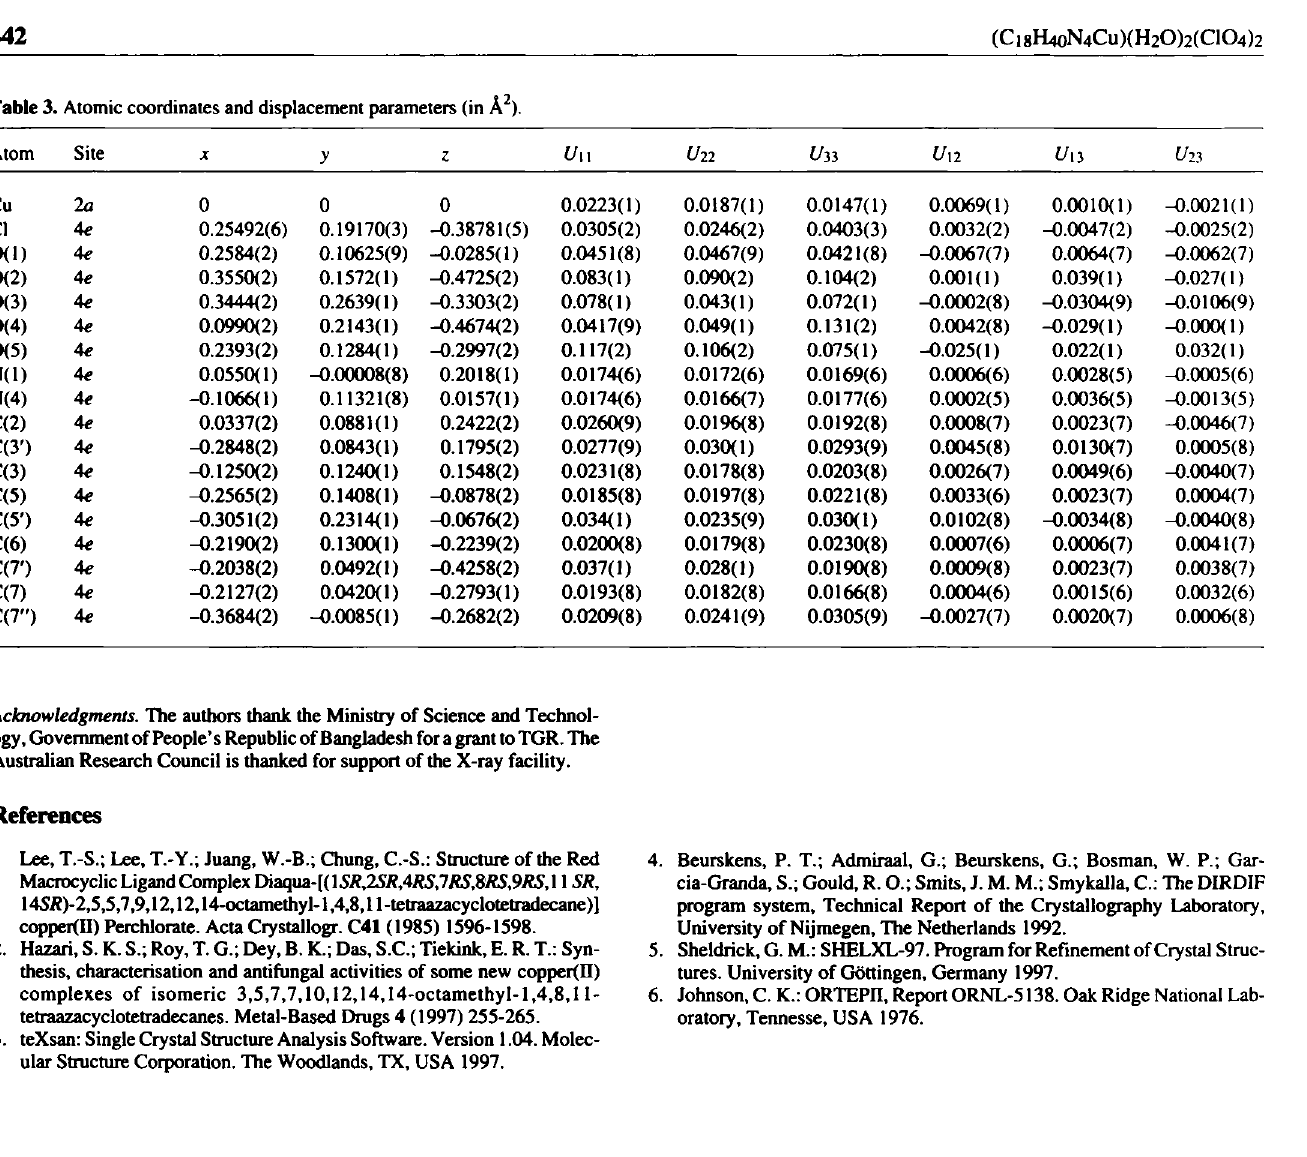
Table 3. Atomic coordinates and displacement parameters (in Ä 2